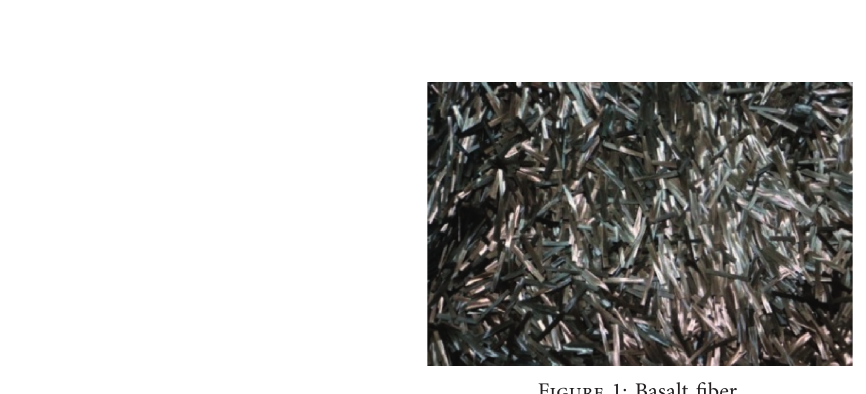
Figure 1: Basalt fiber.